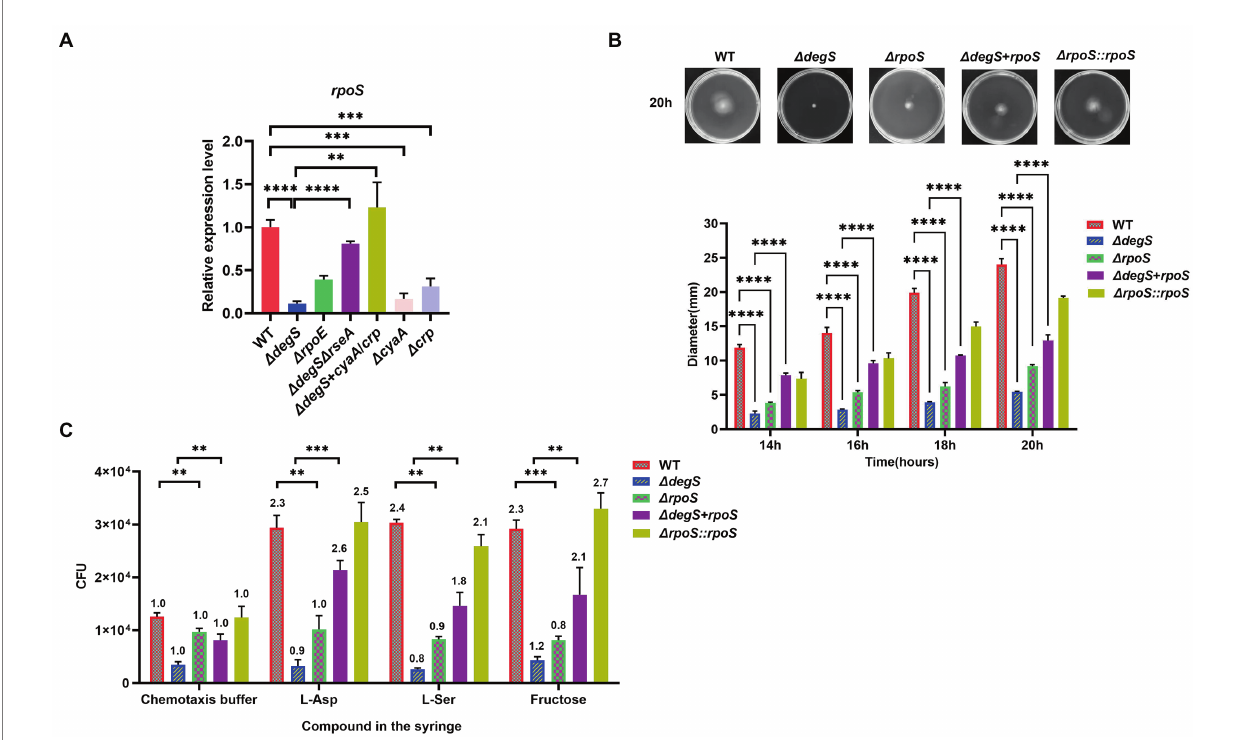
FIGURE 3 RpoS participates in the DegS-mediated regulation of Vibrio cholerae motility. (A) The mRNA levels of rpoS in WT, Δ degS , Δ rpoE , Δ degS Δ rseA , Δ cyaA , Δ crp , and Δ degS + cyaA / crp strains (unpaired t -tests). (B) The swimming motility of WT, Δ degS , Δ rpoS , Δ rpoS::rpoS , and Δ degS + rpoS strains was assessed. The representative pictures for the swimming zones are obtained at 20 h. Statistical analyses were performed using a two-way ANOVA. ***, p < 0.001 and ****, p < 0.0001 between two strains. (C) Analysis of the chemotactic responses to aspartate, serine, and fructose for WT, Δ degS , Δ rpoS , Δ rpoS::rpoS , and Δ degS + rpoS strains. Error bars indicate the SDs based on three replicated experimental values ( n = 3). **, p < 0.01; ***, p < 0.001 (unpaired t -tests). Numbers on top of each bar indicate the relative chemotactic indexes